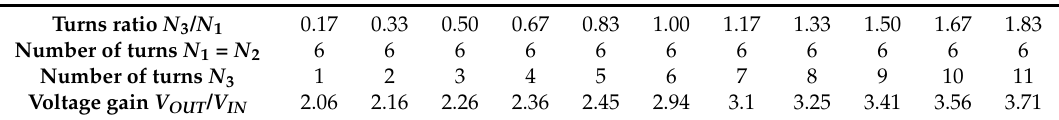
Table 5. Values of the converter’s voltage gain in dependency on the turns ration between boost and